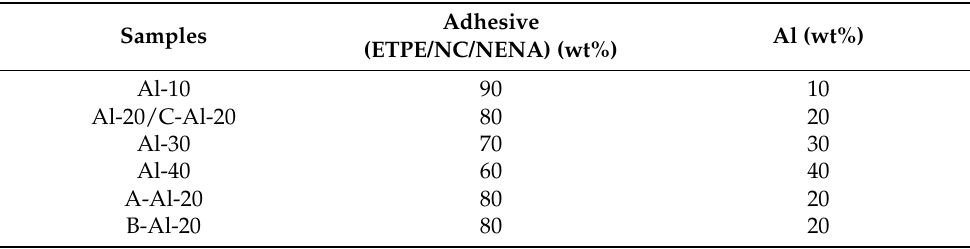
Table 1. Model propellants with different Al contents.